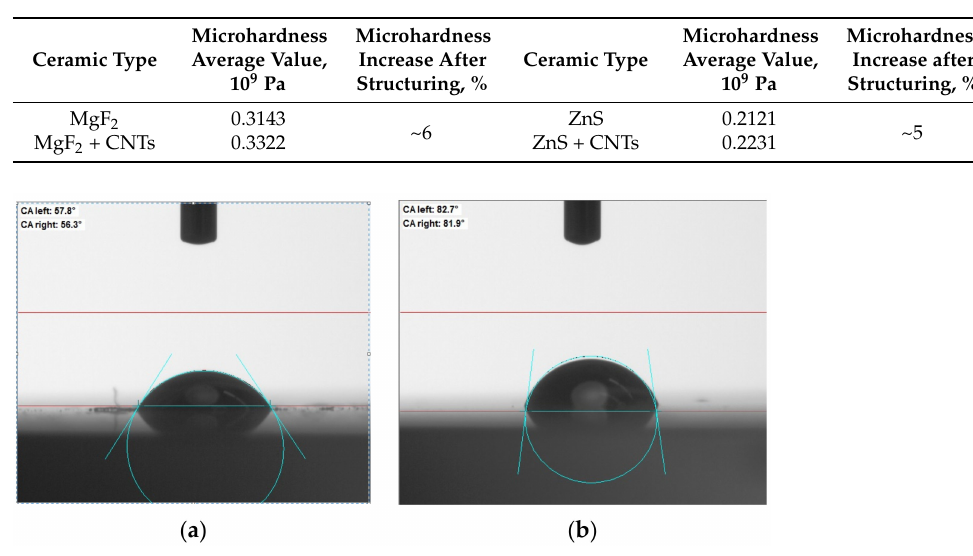
Table 2. Data of the microhardness increase in MgF 2 and ZnS optical ceramics after the deposition of CNTs.